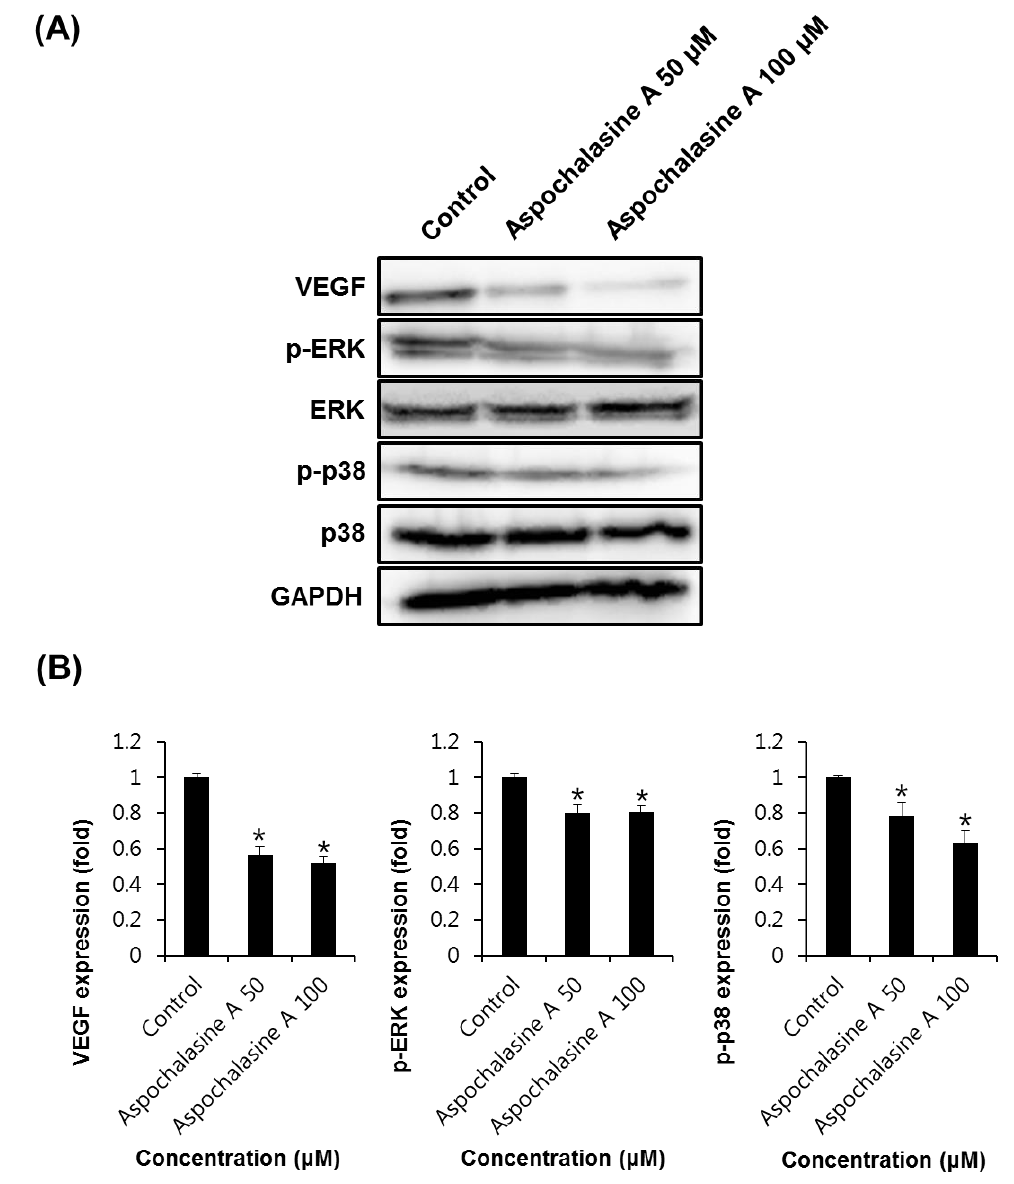
Figure 6. The effect of aspochalasine A on angiogenic protein expression in HUVECs. ( A ) Western blot indicating the levels of VEGF (21 kDa), phosphorylated ERK (42/44 kDa), ERK (42/44 kDa), phosphorylated p38 (38 kDa), and p38 (38 kDa) in HUVECs treated with aspochalasine A at different concentrations for 24 h. ( B ) Graphs representing quantification of effect of aspochalasine A on the angiogenic protein expressions in HUVECs. Data are expressed as mean ± SEM. Similar results were obtained in three independent experiments; * p < 0.05 compared to the control value.